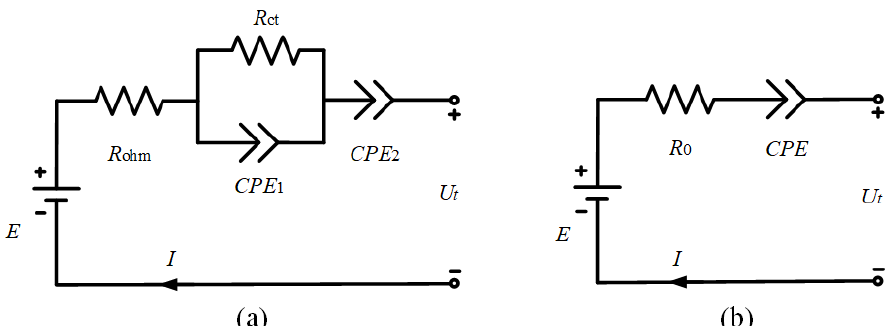
Figure 1. Structure of typical FOMs for LIBs: ( a ) second-order FOM. ( b ) Simplified FOM.